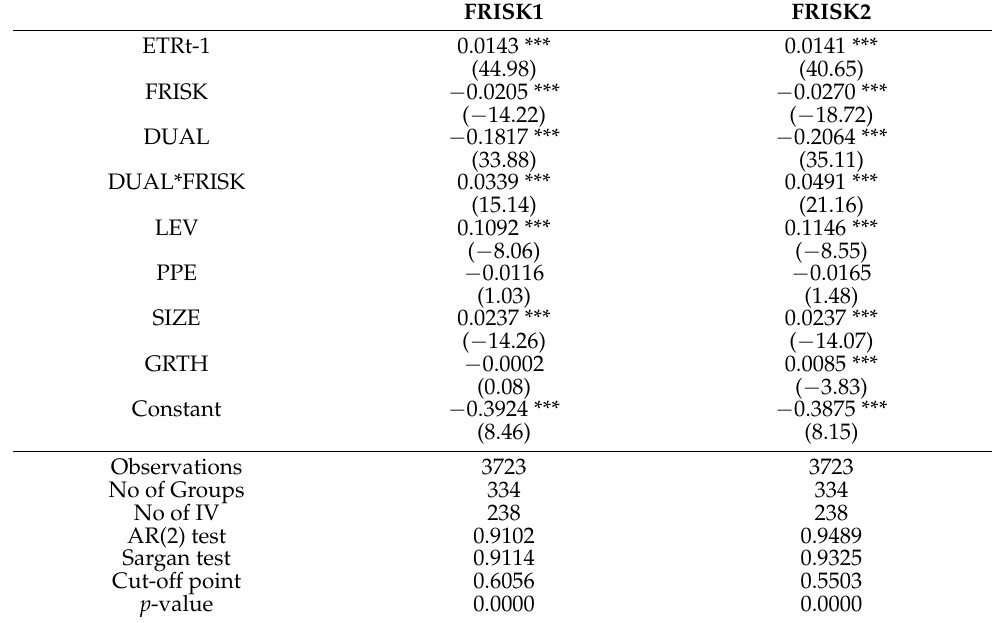
Table 7. The effect of Ceo dual on the relationship between firm risk and the level of tax